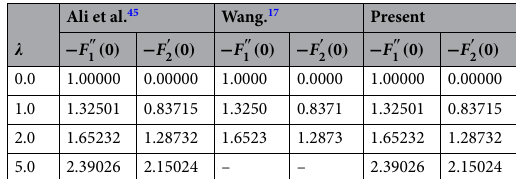
F ′ F ′′ 0 ) and 0 ) for different inputs of (cid:31) at zeta 1 ( 2 ( − −